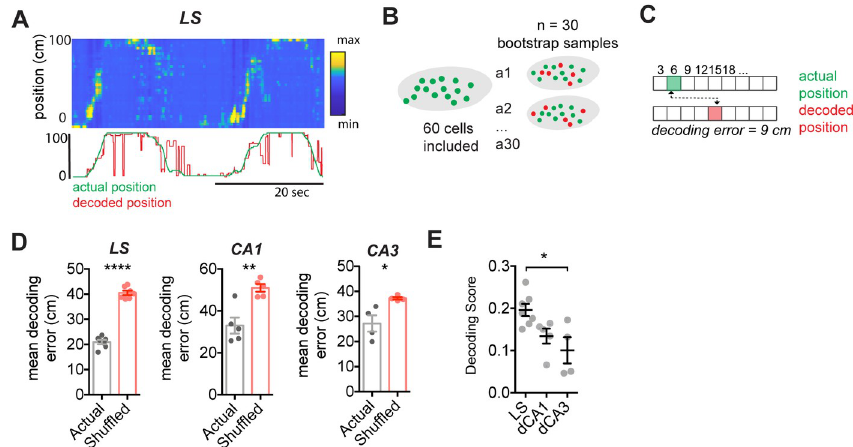
Fig 2. Location can be reliably decoded from LS GABAergic cells. (A) Top: posterior probabilities for each frame estimated from binarized calcium activity; bottom: corresponding actual (green) and decoded (red) location. (B) Schematic representation of bootstrapping approach. (C) Method for computing mean Euclidean distance decoding error (in cm) for each bootstrapped estimate. (D) Decoding error for actual vs shuffled dataset (30 bootstrapped samples of 60 cells, LS: N = 7 mice, CA1: N = 5 mice, CA3: LS = 4 mice). (E) Mean decoding score for each region. � , p < 0.05, �� , p < 0.01, ���� , p < 0.0001. Test used in D, paired t test, E, one-way ANOVA, Holm–Sidak’s multiple comparisons test. The underlying data can be found in S1 Data. LS, lateral